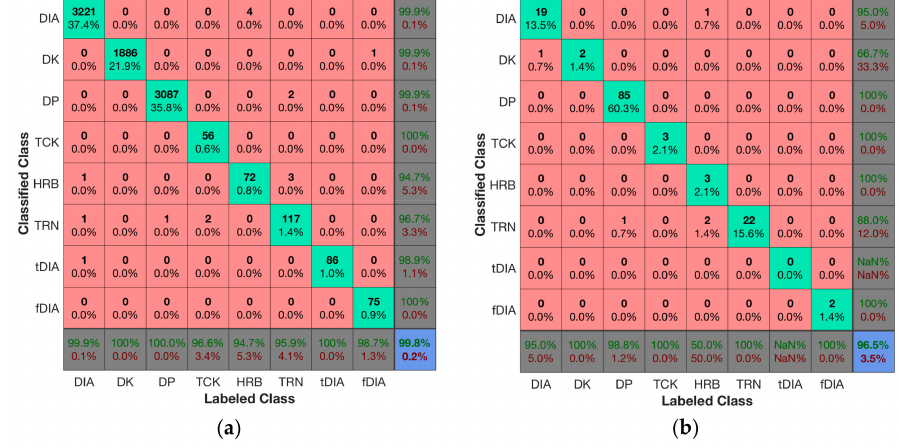
Figure 4. Confusion matrices for the training data ( a ) and validation data ( b ) showing that the overall accuracy for the training data ( a ) was 99.8%, although it dropped to 96.5% for the validation dataset. The accuracy can be read from the lower right element of the matrix, while the bottom row reports the sensitivity for each class, and the right most column reports the precision. The diagonal shows the true positive values for each class (labeled and classified as that class), while the numbers off the diagonal report any confusion between the